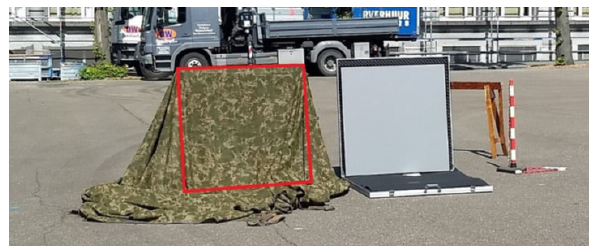
Figure 2. Collection of reference spectra.